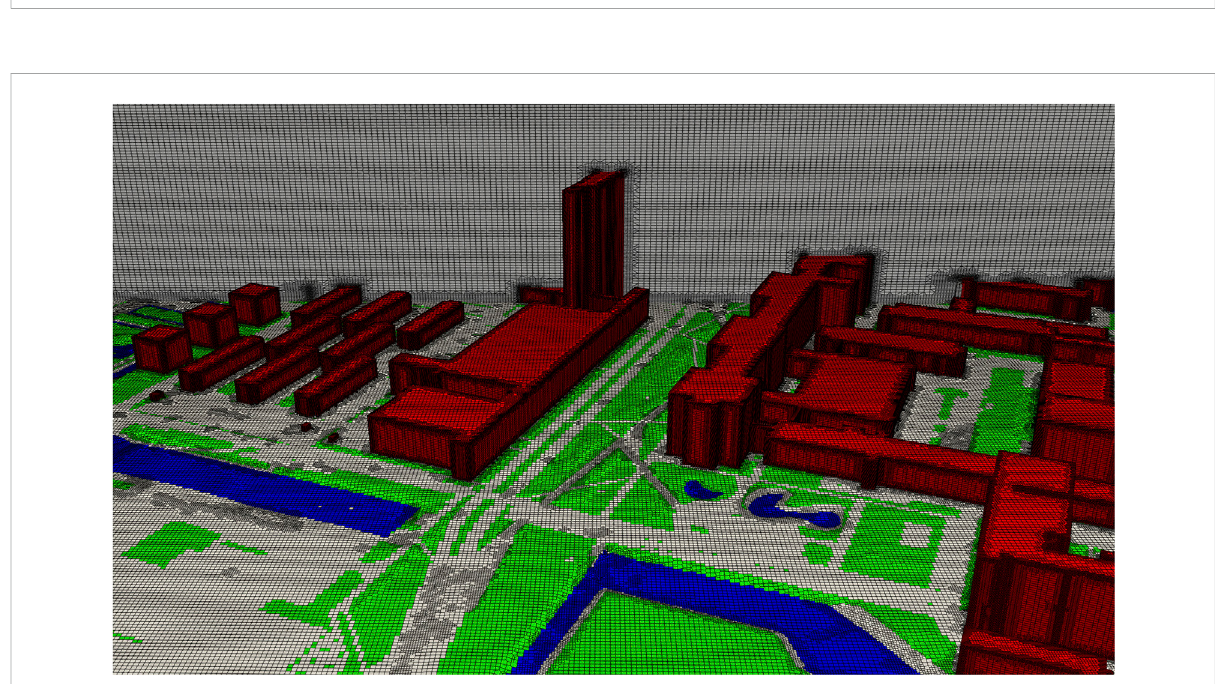
FIGURE 14 Computational mesh (medium) of the TUD campus. Individual patches are shown in different